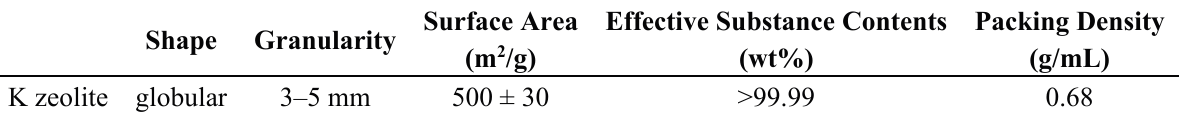
Table 2. Technique specification of K molecules.